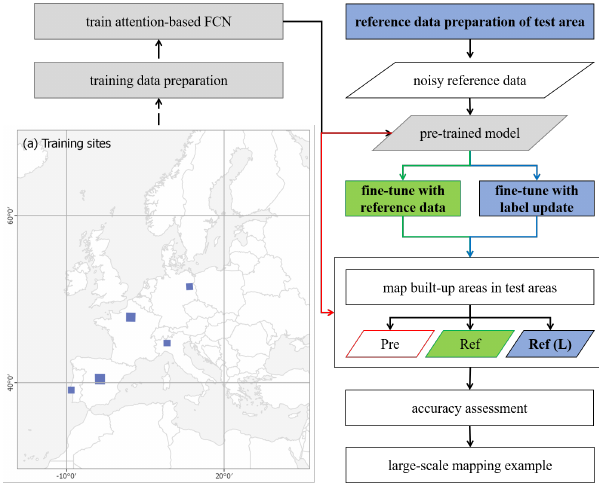
Figure 1. The framework for learning from noisy reference data for impervious area mapping, with the main content